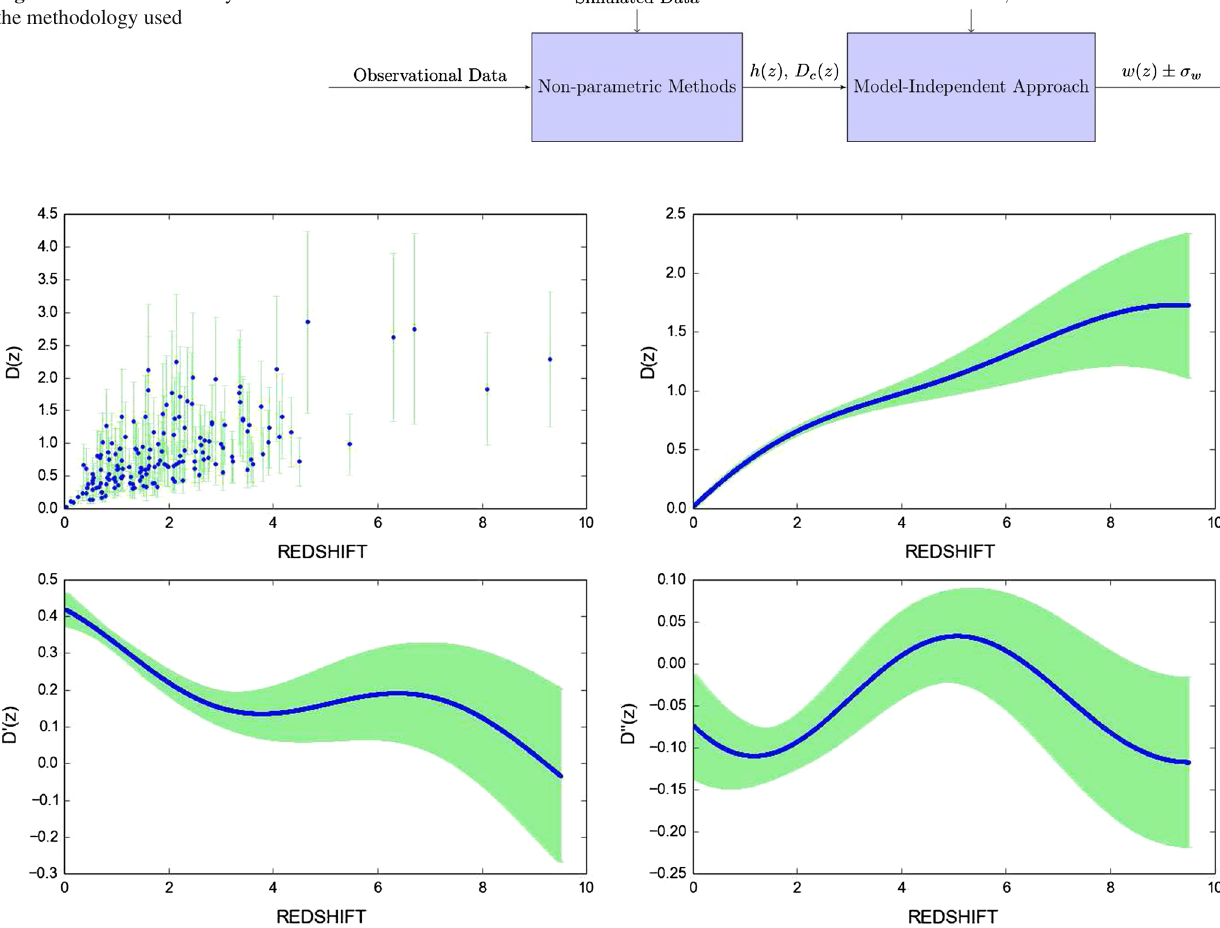
Fig. 1 Schematic summary of the methodology